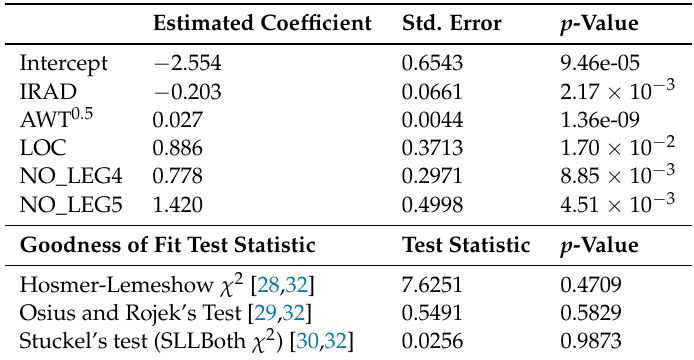
Table 2. Fit of the multivariate logistic regression model E ( Y ) ∼ IRAD + AWT 0.5 + LOC + NO_LEG4 + NO_LEG5 with estimated coefficients, standard errors of the estimates and p -values for the Wald statistic (z) and goodness-of-fit summary